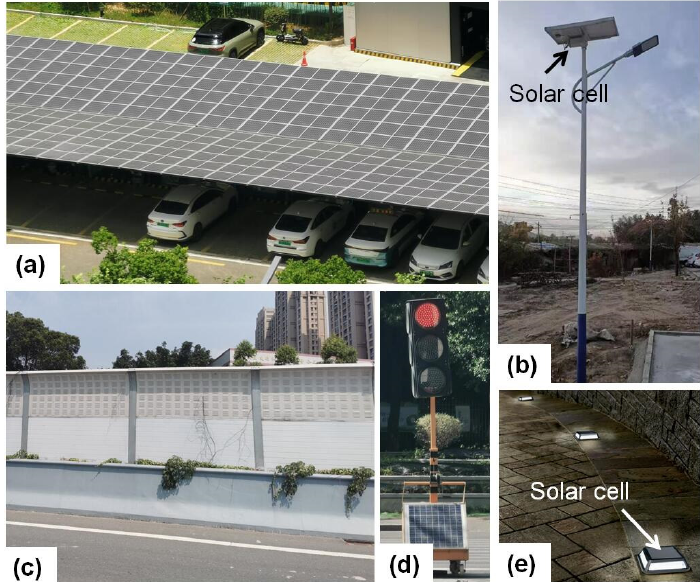
Figure 2. Applicable scenarios in road facilities: ( a ) parking lots, ( b ) lighting, ( c ) noise/wind barrier, ( d ) traffic lights and ( e ) traffic